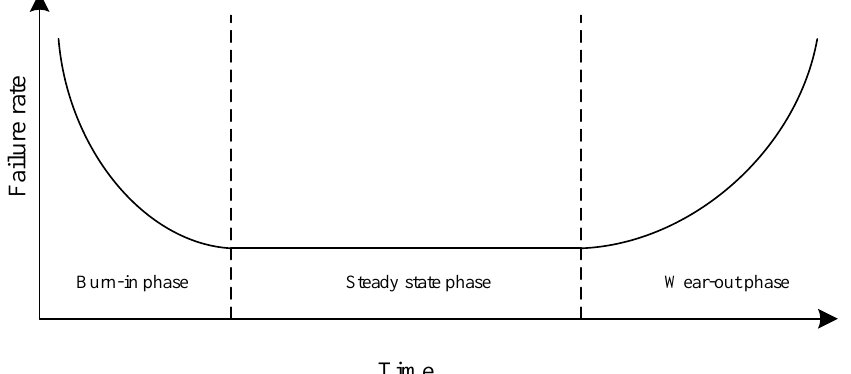
Figure 1. Diagram of bathtub